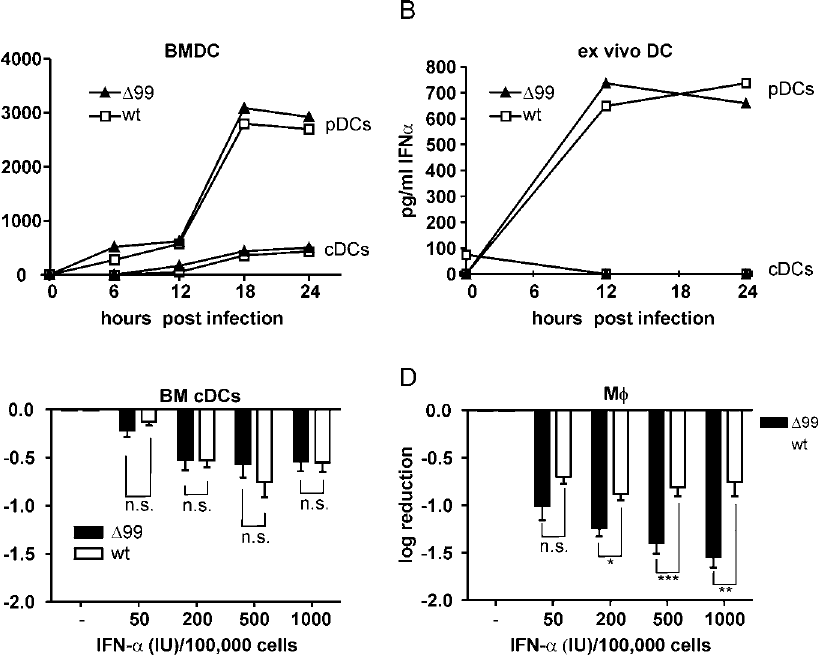
Figure 4. Effect of nsp1 on IFN- a Production and Signaling C57BL/6 bone marrow–derived (A) or primary (B) splenic cDCs or pDCs were infected with MHV-nsp1 D 99 or MHV-A59 at an MOI of 1. IFN- a secreted into cell culture supernatants was determined by ELISA at the indicated time points. Bone marrow–derived cDCs (C) or inflammatory macrophages (D) from 129Sv mice were treated with 50, 200, 500, or 1,000 U IFN- a /100,000 cells or left untreated. Four hours later, cells were infected with MHV-nsp1 D 99 or MHV-A59 (MOI ¼ 1). Twelve hours p.i., virus titers in culture supernatants were determined by plaque assay. Representative experiments out of two (A, B) or the mean 6 SD of two independent experiments (C, D) are shown. Statistical analysis was performed using Student’s t -test (***, p , 0.001; **, p , 0.01; *, p , 0.05; n.s., p .